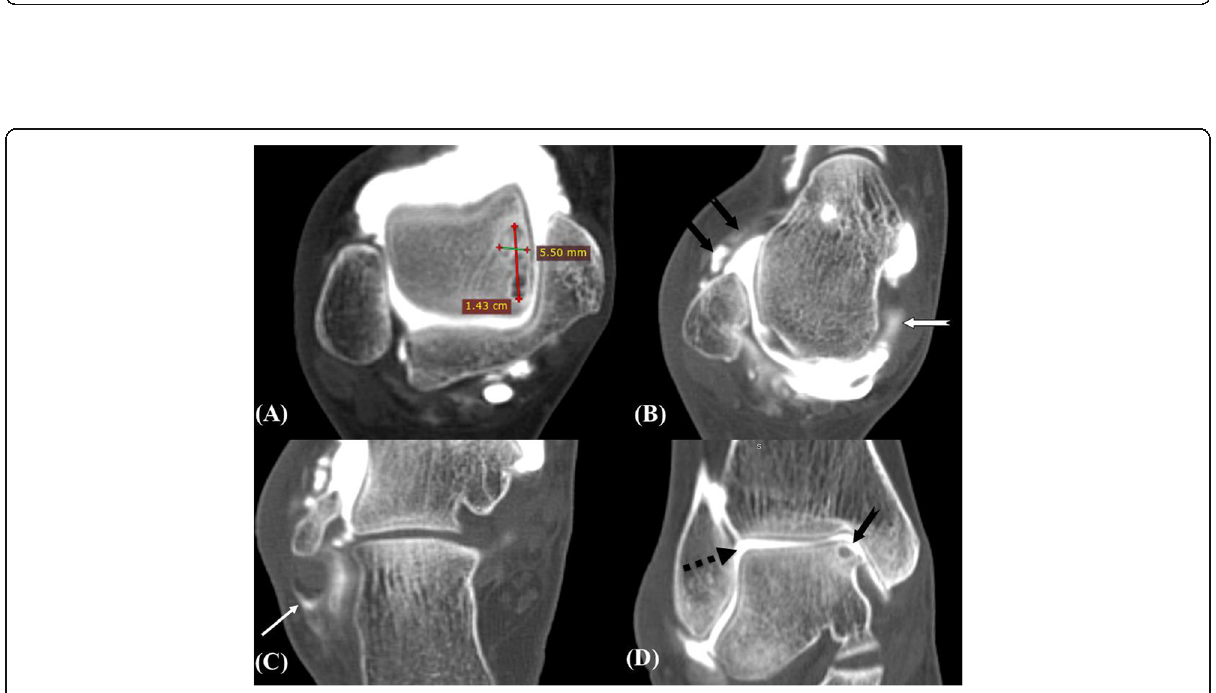
Fig. 4 Chronic diffuse ankle pain after four episodes of ankle sprains, the current episode was lateral sprain. Axial CTA through the talar dome ( a ) demonstrates large medial OCL with cystic changes (type IIA). Axial CTA through the talar neck ( b ) demonstrates bowed ATFL (black arrows) with thin fibers at the lateral malleolar attachment. The deep deltoid ligament shows contrast medium within its posterior band (white arrow) indicating its injury. Axial CTA ( c ) through the calcaneus show contrast within the peroneal tendon sheath indicating CFL tear. Coronal CTA ( d ) shows uneven joint space that appears widened laterally (dashed arrow), note the cartilage loss overlying type IIA OCL at medial talar corner (notched